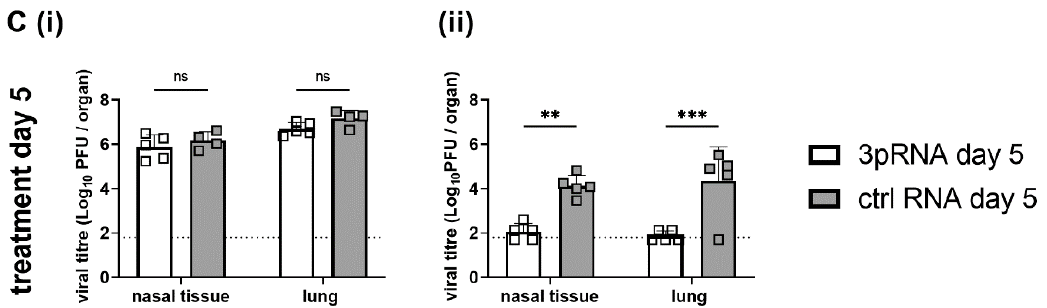
Figure 6. After a single intravenous injection of mice with RIG-I agonist, expression of a functional Mx1 protein is critical for potent and long-lasting protection from subsequent IAV challenge. B6-WT and B6.A2G- Mx1 mice received a single i.v. injection of 12.5 µ g RIG I agonist (3pRNA) or control RNA (ctrl RNA). At either 1 or 5 days after treatment mice were infected by the i.n. route with 10 2 PFU (B6-WT) or 10 6 PFU (B6.A2G- Mx1 ) of IAV strain PR8 (H1N1) in 50 µ L of PBS. ( A ) Mice were monitored daily, and data shows the mean percent ( ± SEM) of weight change over time determined relative to original body weight. ( B , C ) Nasal tissues and lungs were harvested 5 days after infection, homogenized and virus titres in clarified homogenates were determined by plaque assay on MDCK cells. Data are expressed as mean ± SD ( n = 4–5/group). Dashed lines represent the limit of detection of the plaque assay. Samples below the detection limit (<1.8 log 10 PFU/mL) were assigned a value of 1.7 log 10 PFU/mL for statistical analysis. ( A ) Student’s t -test was performed to compare weight loss after 3pRNA or ctrl RNA treatment. ( B , C ) Two-way ANOVA with Bonferroni’s multiple comparison test was performed to compare weight loss and viral titres after 3pRNA or ctrl RNA